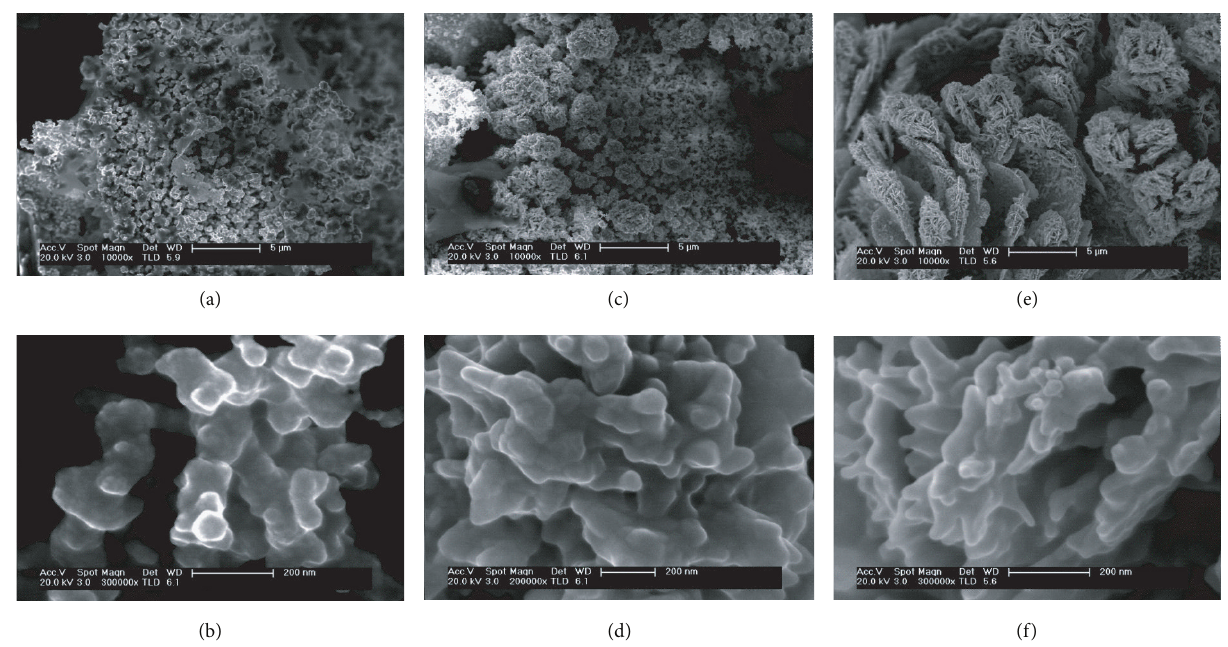
Figure 3: SEM images of NPC-G 1 number ((a), (b)), NPC-G 2 number ((c), (d)), and NPC-G 3 number ((e),